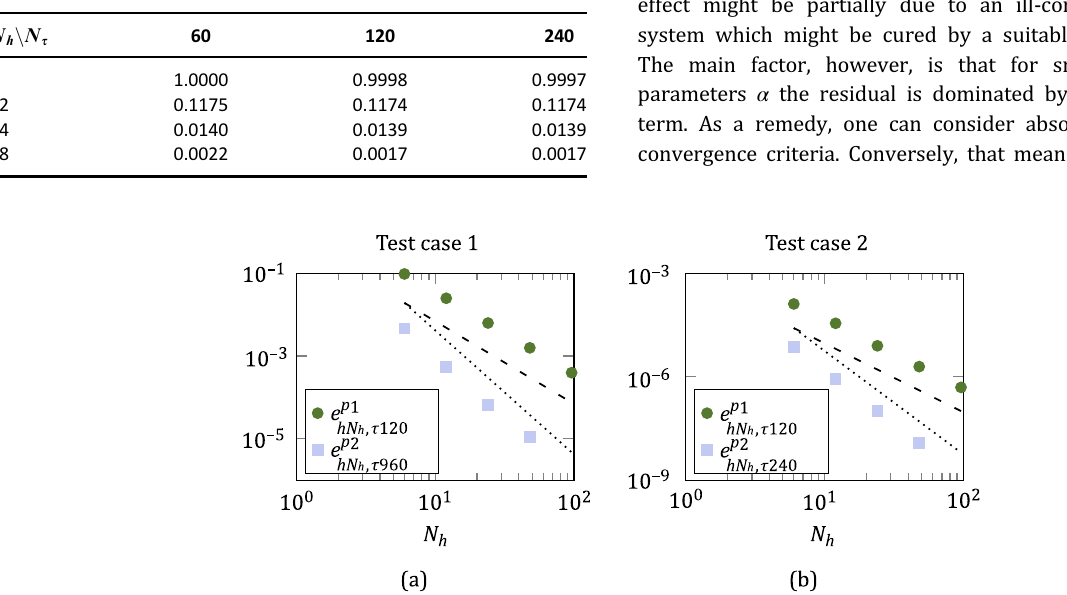
for Test Case 1 (a) for hN h ; s N s